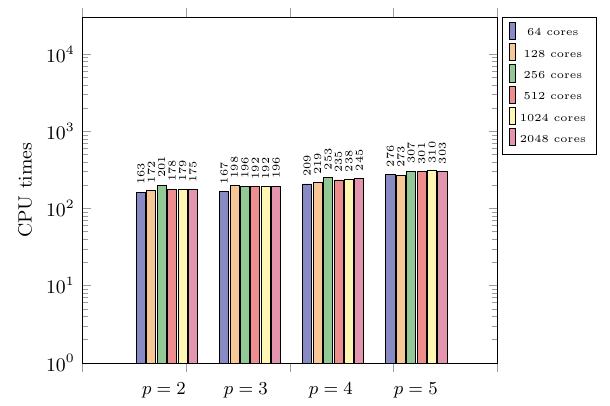
Fig. 12 Weak scalability study for MGRIT using V-cycles and back- ward Euler on the unit square. Here p -multigrid is used for all spa- tial solves within